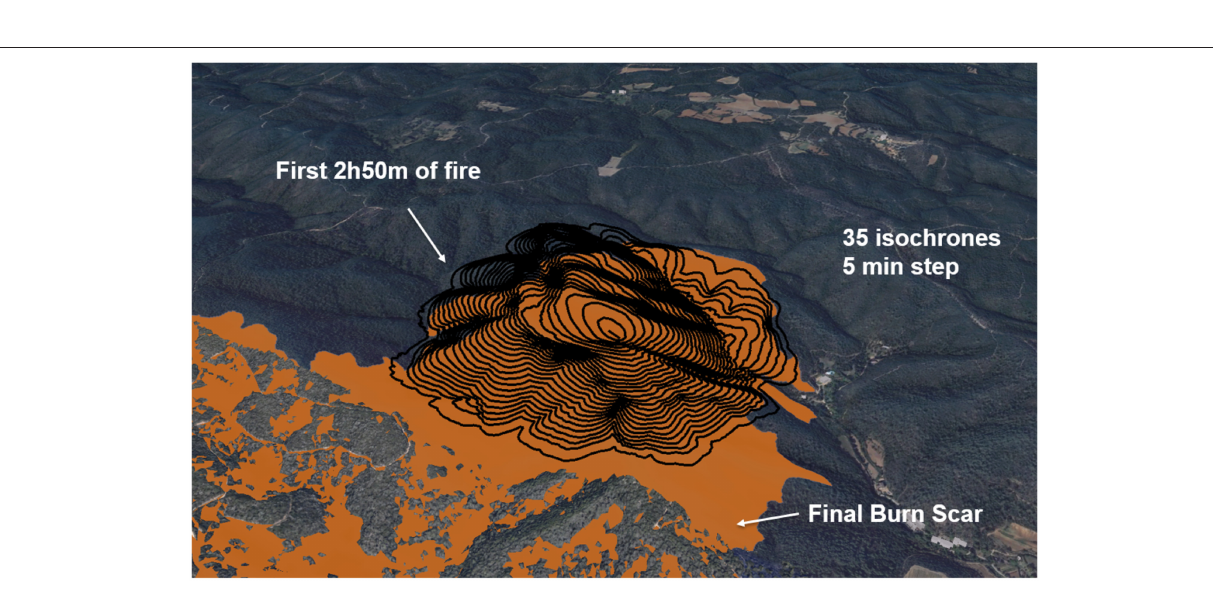
Frontiers in Mechanical Engineering |